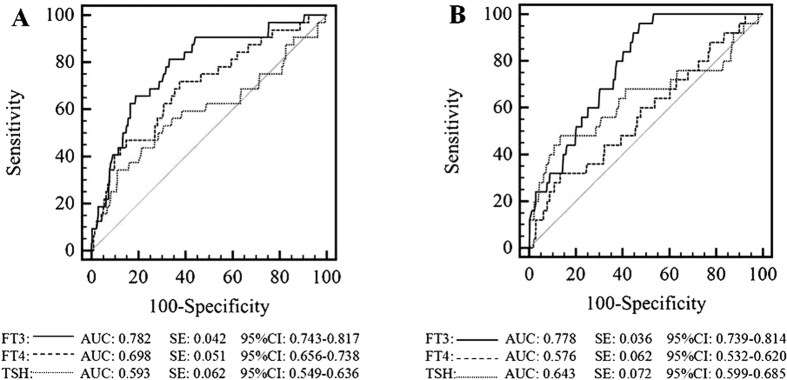
ROC curves for FT3, FT4, and TSH for 30-day mortality (A) and ICU admission (B).